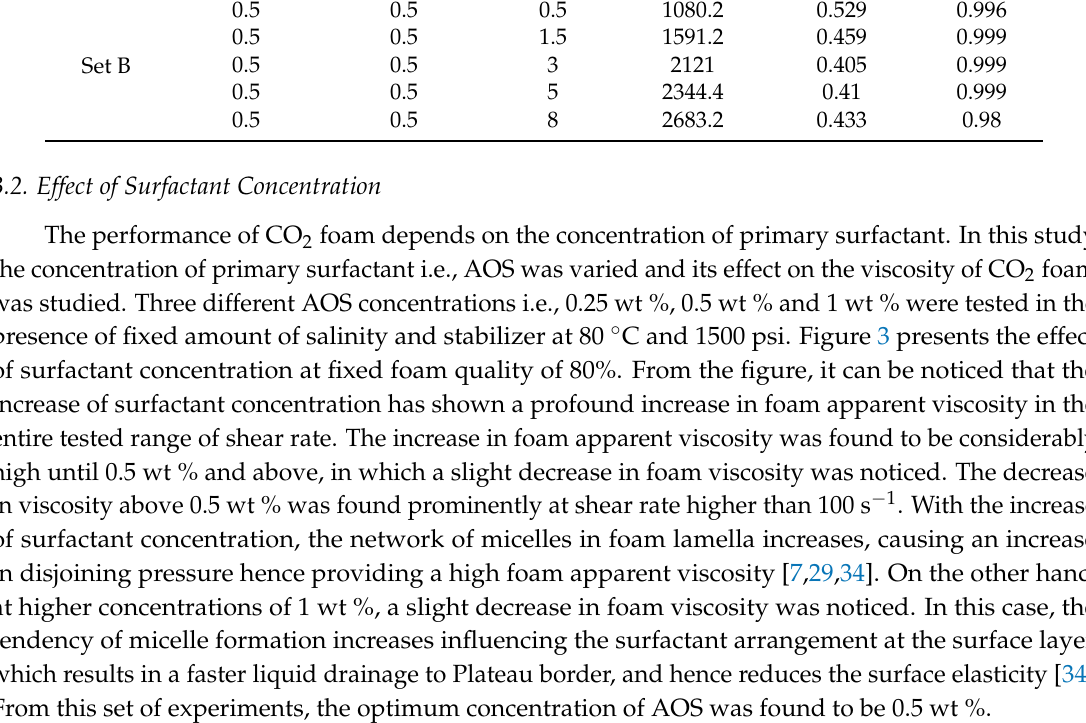
Table 1. Power law parameter estimates for CO 2 foams.